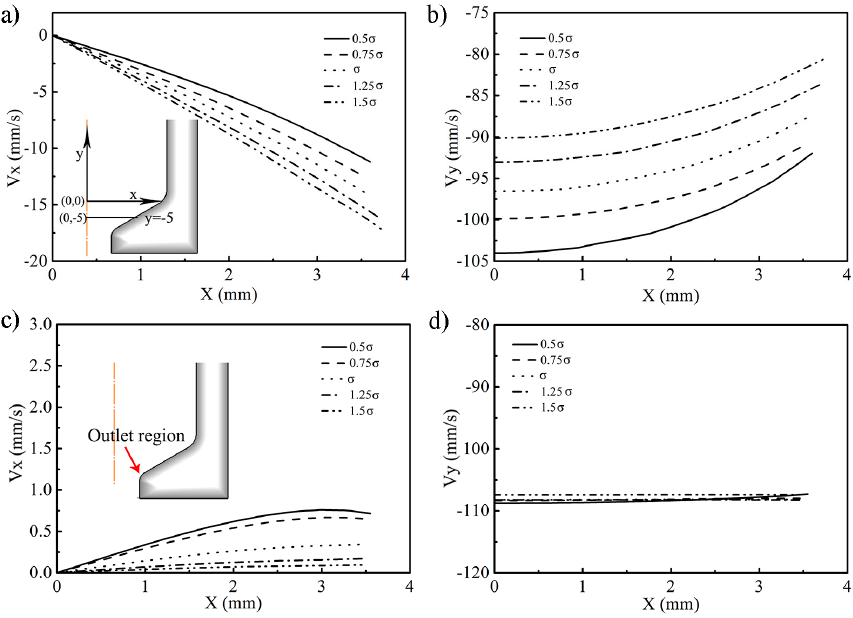
Figure 4. Flow velocity of the different filler materials at horizontal line y = − 5 mm ( a ) X axis direction; ( b ) Y axis direction; and outlet region ( c ) X axis direction; ( d ) Y axis direction.